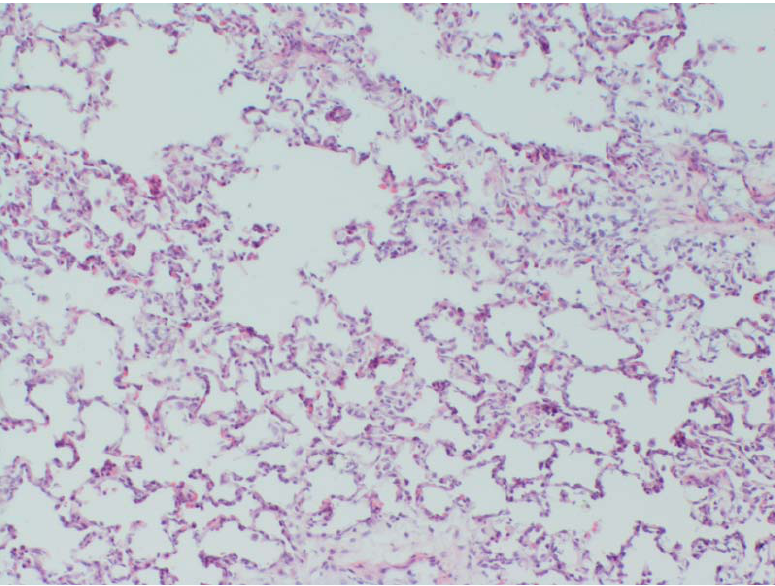
Figure 9. Interstitial pneumonia in animal No. 2. Lungs with increasing round cellular content in alveolar septa and in some places groups of cells in alveolar lumen are present. HE staining, 4×.